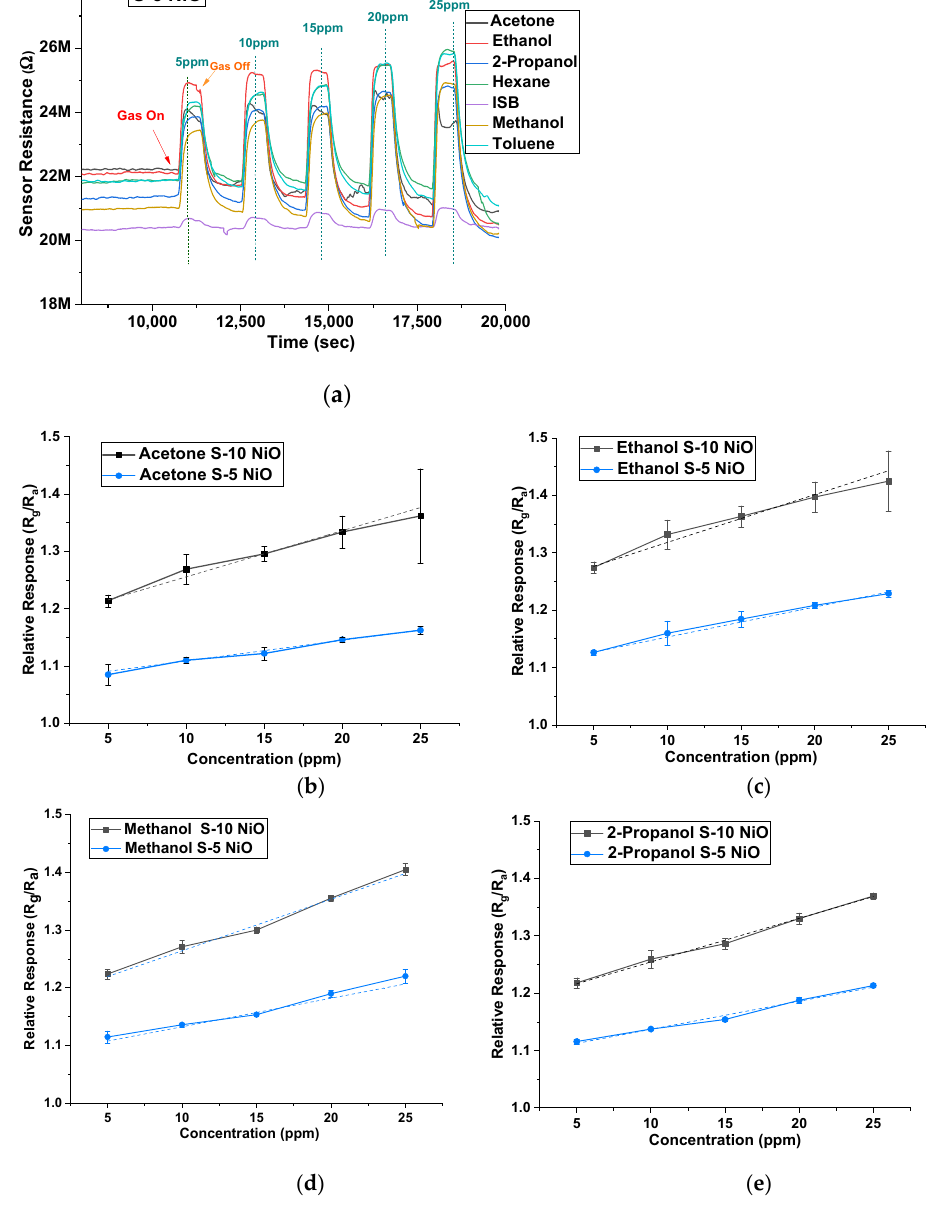
Figure 6. ( a ) Sensor response profile of S-5 NiO towards all the VOCs at 350 °C at 40% r.h. Concen- tration versus sensitivity of S-5 and S-10 sensors at 40% r.h. of: ( b ) acetone; ( c ) ethanol; ( d ) methanol; ( e ) 2-propanol.